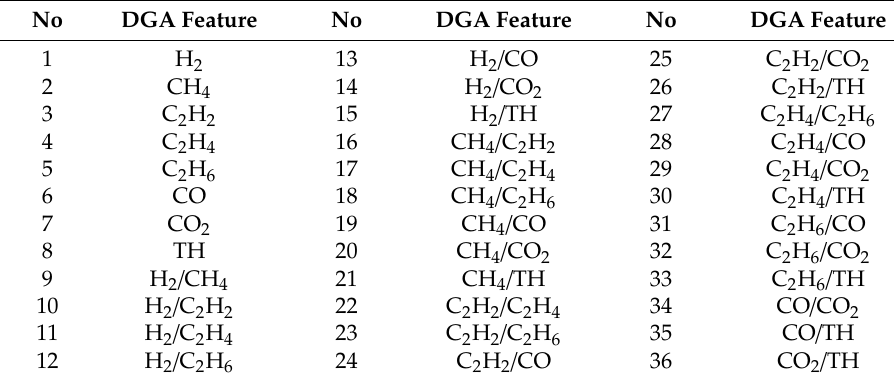
Table 1. DGA features to be selected.